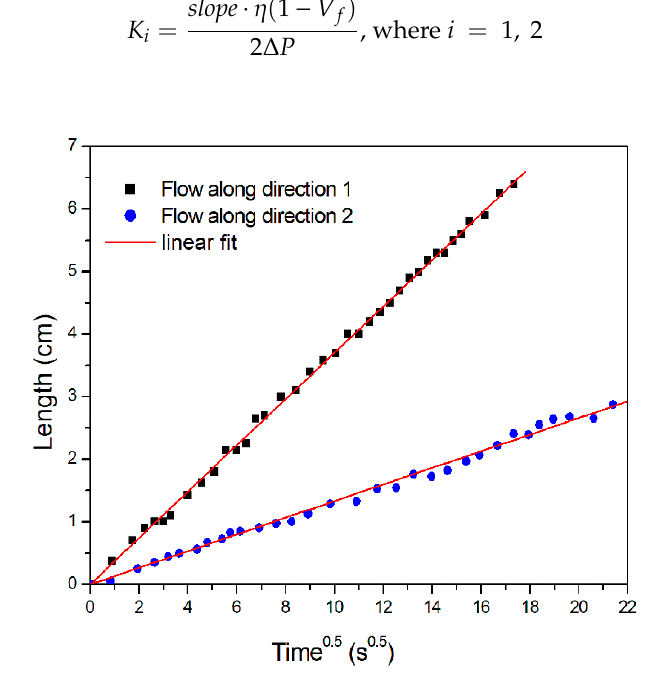
Figure 5. Flow front position along 1 and 2 direction as a function of the square root of time for TX 1100 preform.